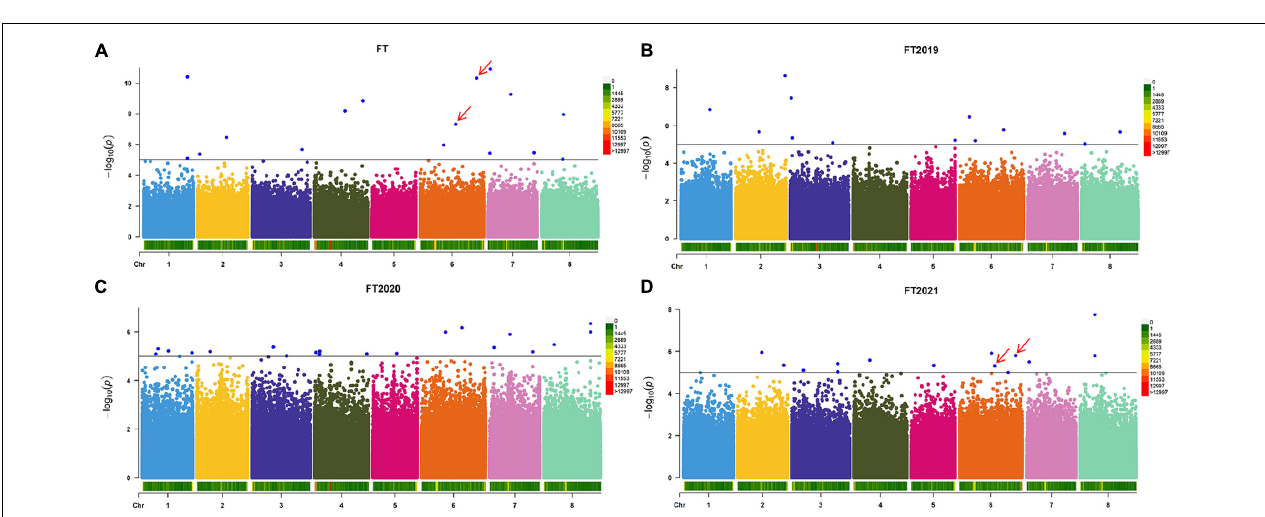
FIGURE 2 | Manhattan plot of the flowering time in different years. (A) Manhattan plot of the average flowering time over three years. (B) Manhattan plot of the flowering time in 2019. (C) Manhattan plot of the flowering time in 2020. (D) Manhattan plot of the flowering time in 2021. The GWAS was performed by BLINK C software, and the threshold for significantly associated loci was an LOD score ≥ 5 (blue line). The red arrow indicates the SNP sites co-located with two years of phenotypic